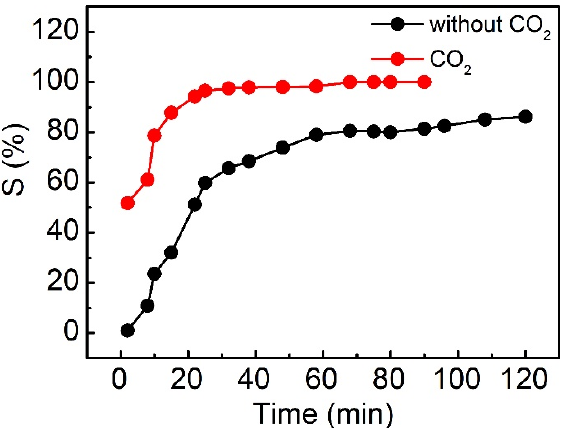
Figure 9. The effect of CO 2 on the viscosity in the viscosity-reducing system. The total concentration of OA and cyclen (molar ratio = 4:1) was 3.0 wt%, and the mass ratio of oil and OA/cyclen aqueous solution was set as 7:3.